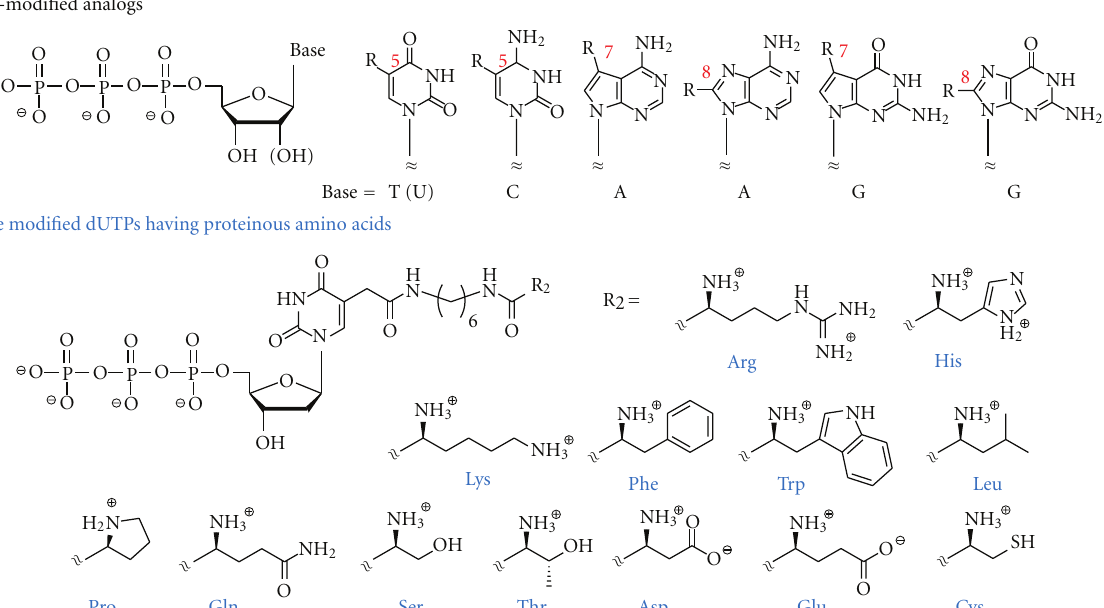
Figure 2: Examples of modified nucleoside triphosphates that act as substrates for polymerase